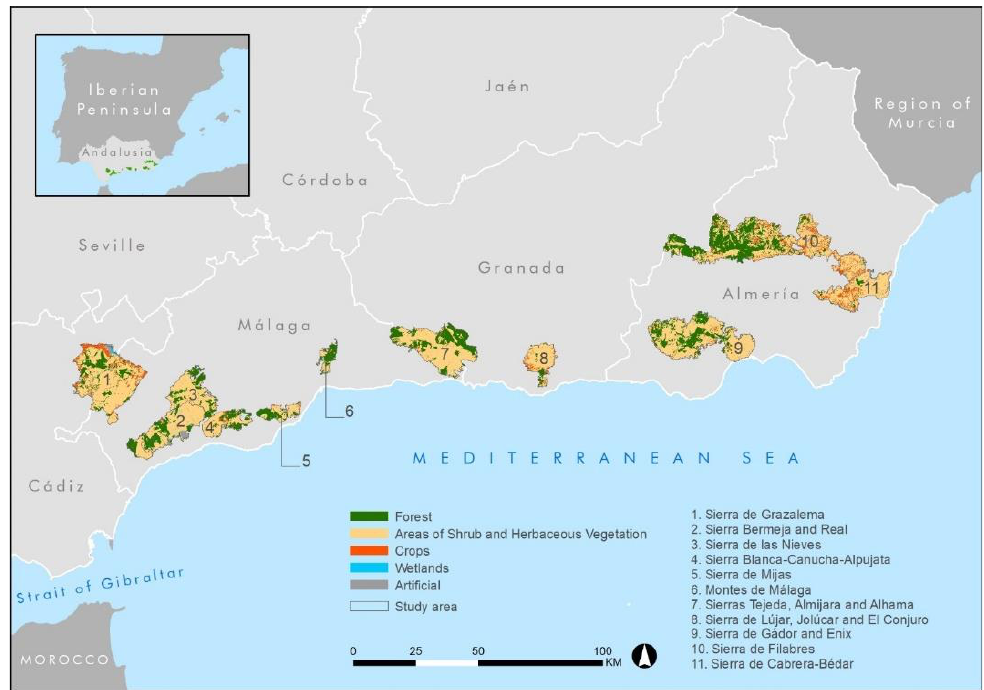
Figure 3. Location of land uses of natural areas in 2021. Own elaboration based on data of the Geographical Information System for the Identification of Agricultural Land Parcels (SIGPAC) (2021).